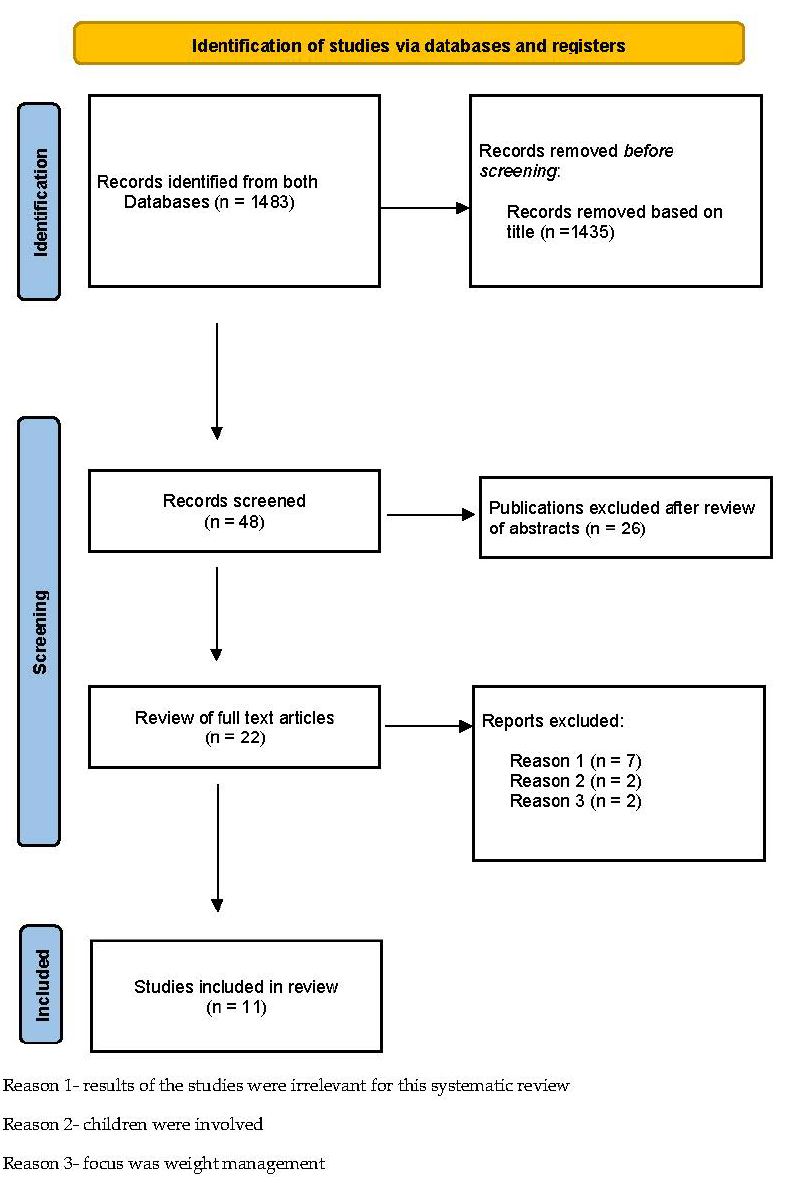
Figure 1. Identification of chosen studies via database registers.